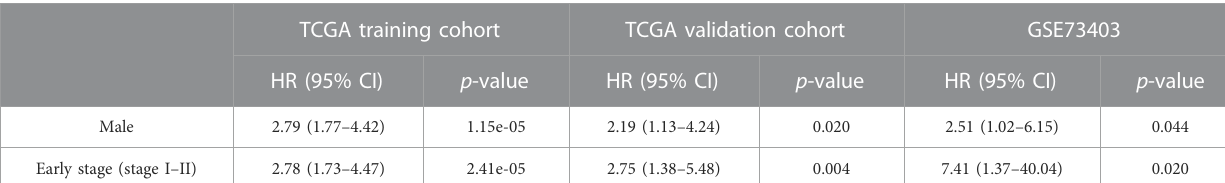
TABLE 2 Subgroup analysis of the MSI-PRS in all LUSC cohorts.